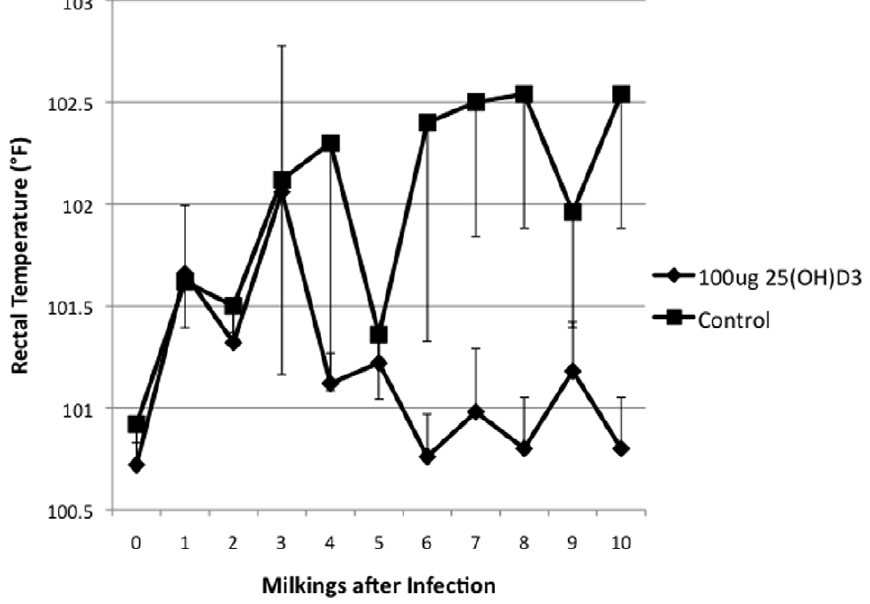
Figure 2. Rectal Temperature in Control and 25(OH)D 3 Treated Animals. Rectal temperature were taken twice daily, at each milking, and the average was determined for 25(OH)D 3 treated ( u ) and control animals( n ).